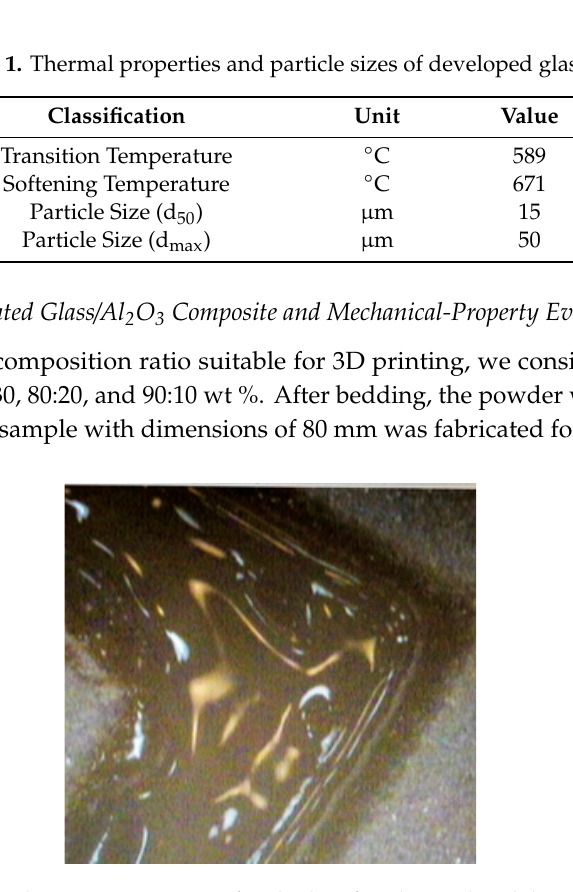
Figure 6. Optical microscope image of melt glass frit obtained with laser scanning.